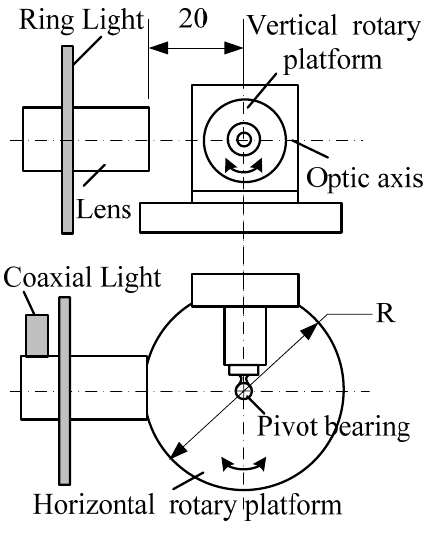
Figure 6. Framework map of the detection system.